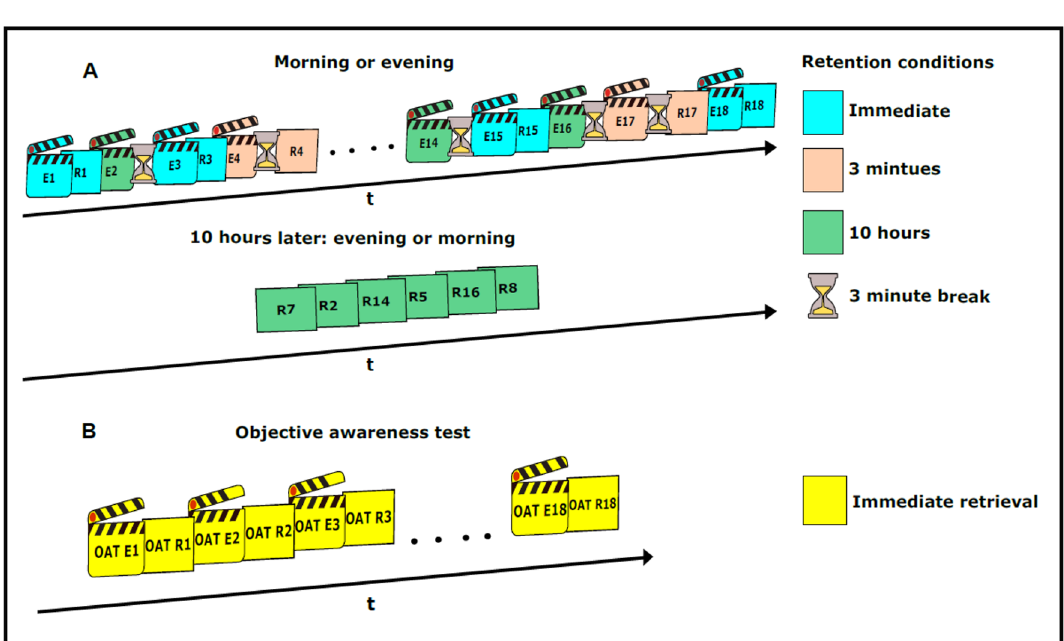
Figure 2. Experimental procedure. ( A ) Eighteen cartoon clips were presented subliminally/supraliminally for unconscious/conscious encoding. A 3-min silent break followed clip presentations both in the 3-min and 10-h retrieval condition. ( B ) We ran an objective test of clip awareness with 18 strongly masked clips at the end of the experiment. Here, retrieval testing was prompted immediately after clip offset. OAT, objective awareness test; E, encoding; R, retrieval; 1–18: number of cartoon